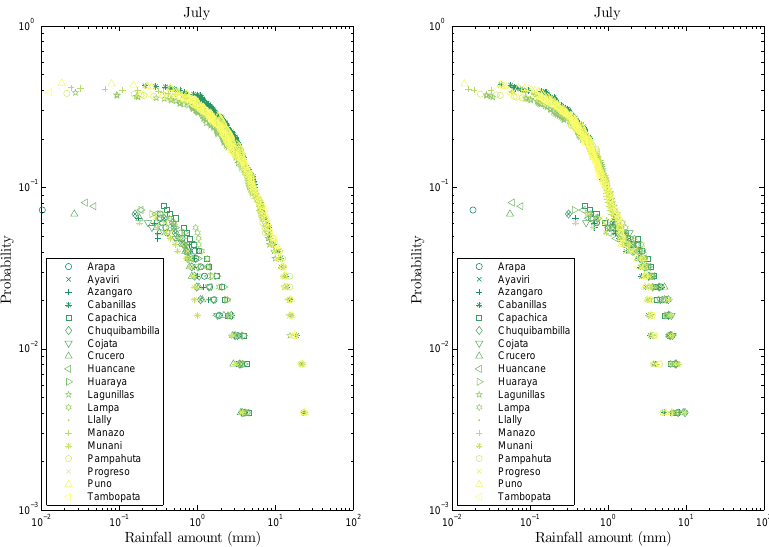
Figure 19. Exceedance probability plots for July over an 8-year period of (right panel) TRMM data ( R rainfall field) and (left panel) TRMM with long-term averages (monthly) removed ( M rainfall field).